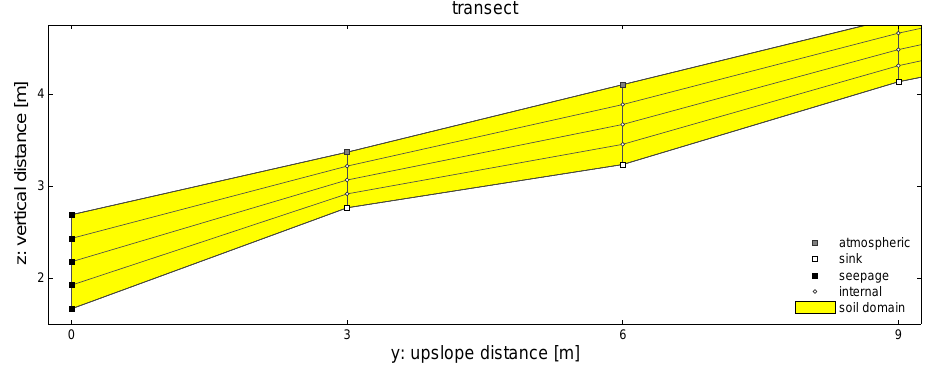
Fig. 1. Transect of lower section of the domain with boundary node types shown. Infiltration enters the domain at the atmospheric boundary nodes. Excess water is removed from the domain either vertically at the sink nodes, or laterally as seepage. 6 Table 1. Overview of the most relevant parameters in the SWMS 3D model.